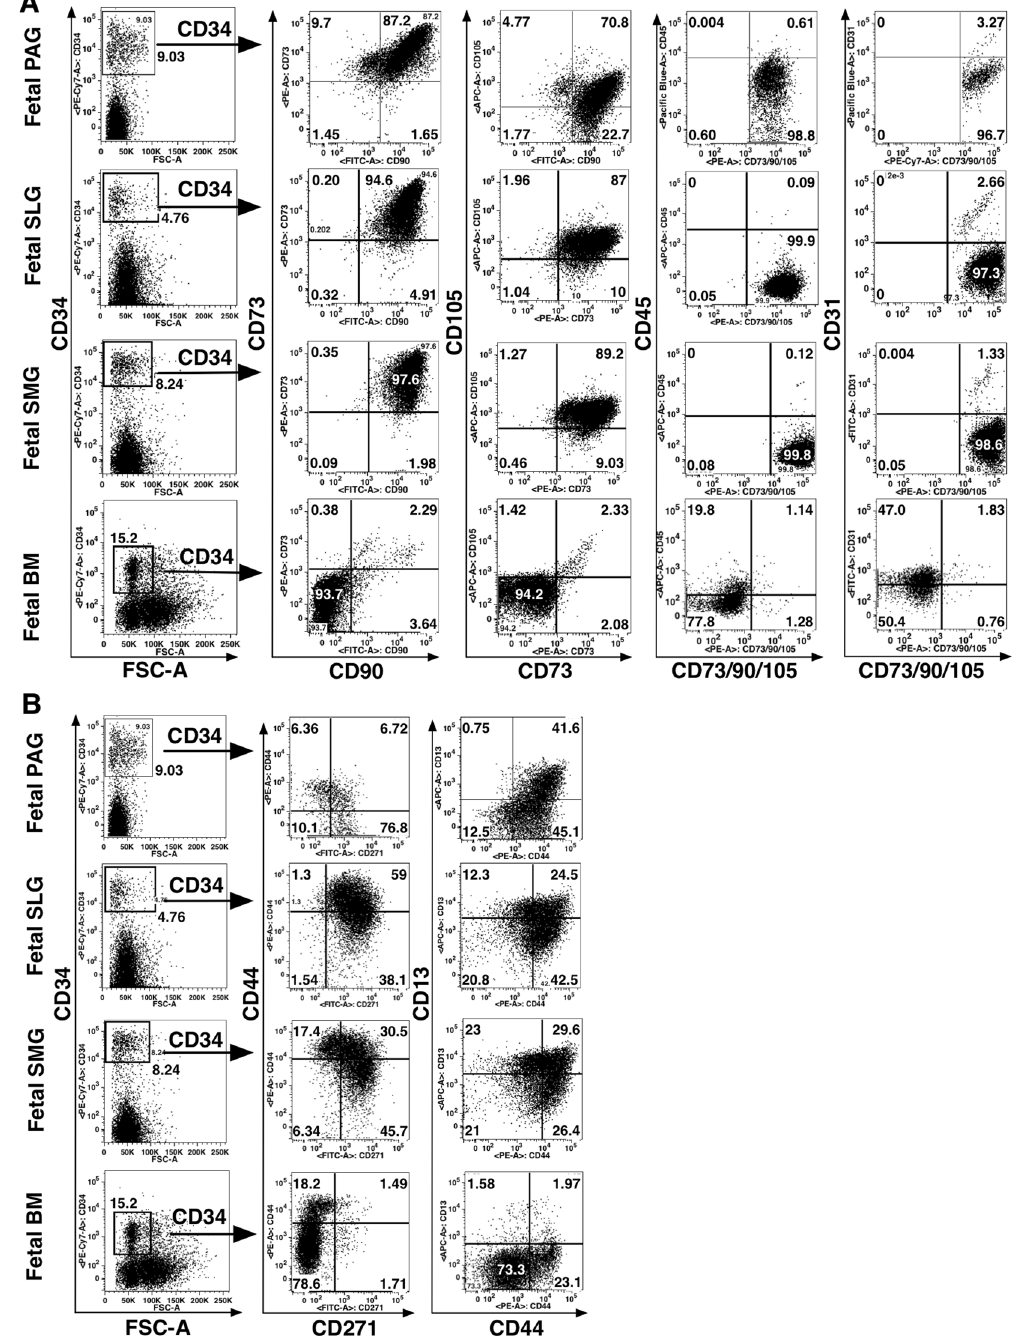
CD44, CD271 and CD13 on total CD34 +